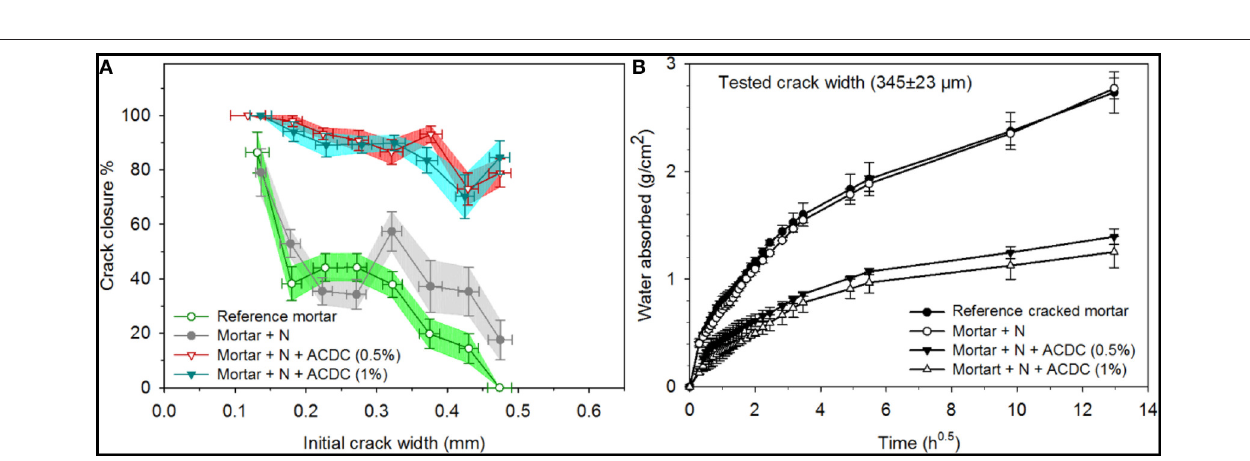
FIGURE 10 | The enhanced self-healing performance of the 6 months old microbial specimens over the control specimens (A) the crack closure performance (horizontal error bars represent the standard deviation, crack widths were grouped with 50 µ m intervals, vertical error bars represent the standard error of the mean, n ≥ 5) (B) capillary sorption around the crack zone of the healed specimens [N: Nutrients – 2% Ca(HCOO) 2 + 3% Ca(NO 3 ) 2 ; the error bars represent the standard deviation, n = 3